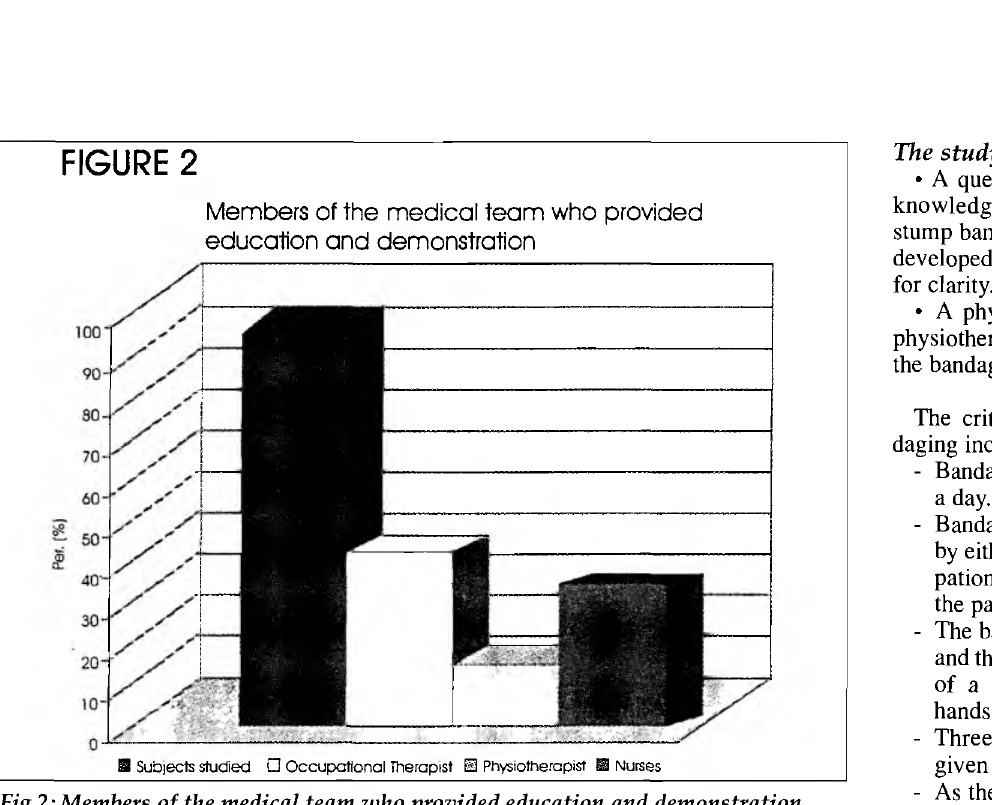
Fig 2: Members of the medical team who provided education and demonstration